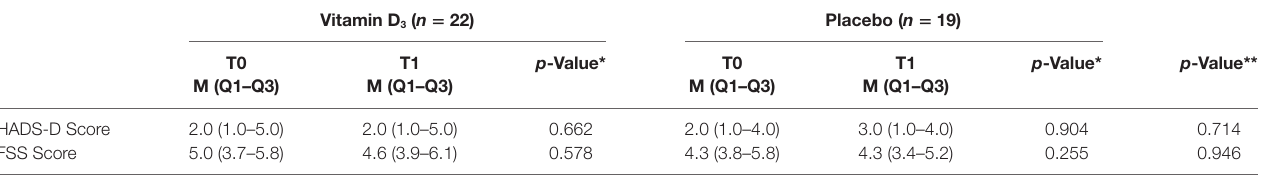
Table 4 | Within and between group comparisons for depression and fatigue